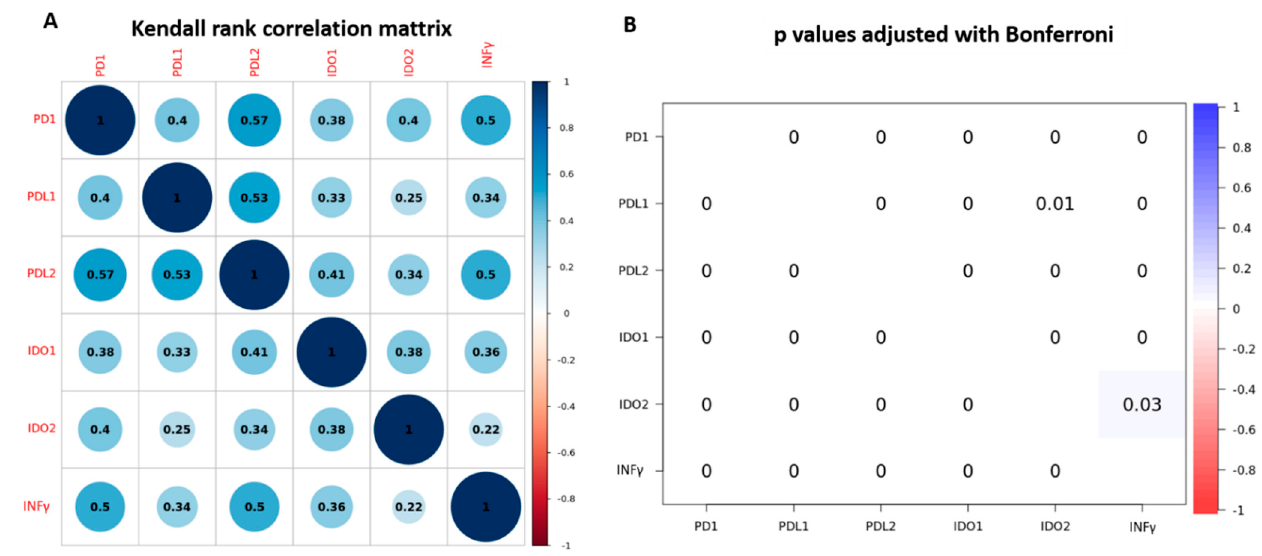
Figure 1. Correlation among the expression levels of immune-related genes. ( A ). Kendal rank correlation matrix. ( B ). Probability significative test was adjusted using Bonferroni.